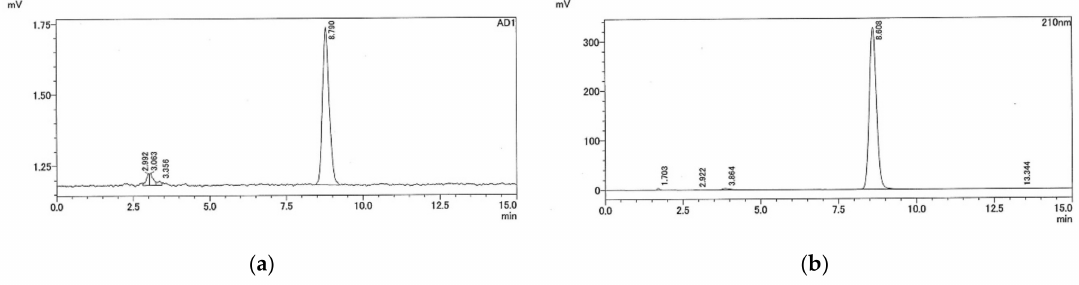
Figure 1. Reversed-phase high-performance liquid chromatography (HPLC) radio-ultraviolet (UV) chromatograms: ( a ) 99m Tc-N 2 S 2 ; ( b ) Re-N 2 S 2